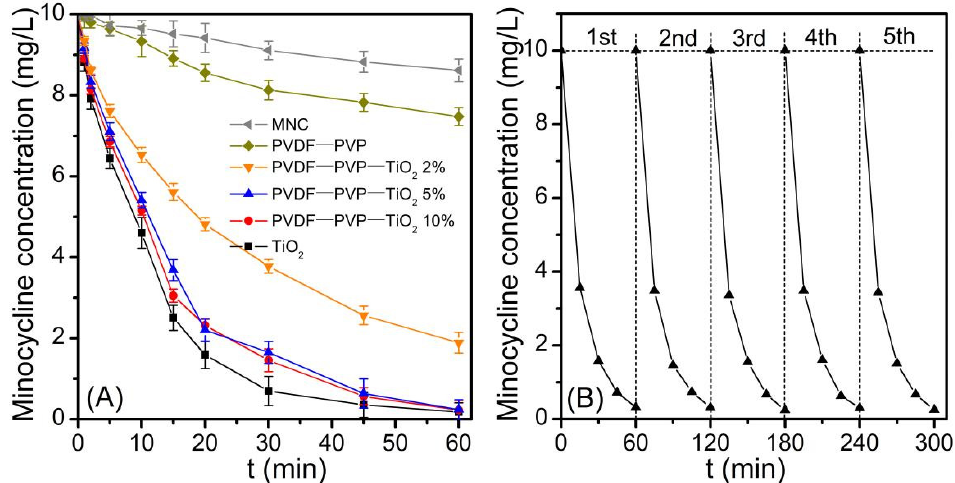
Figure 4. ( A ) Removal of minocycline ([minocycline] 0 = 10 mg/L) by adsorption and photocatalytic